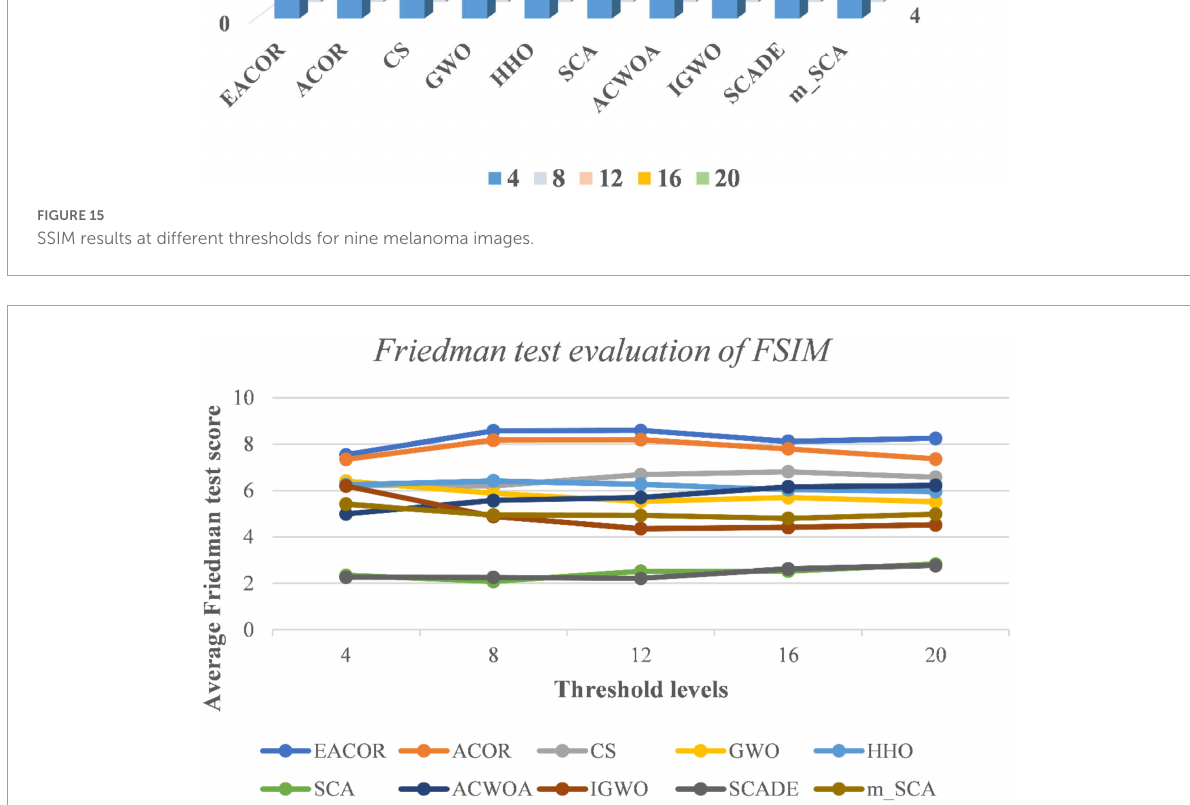
FIGURE16 FT result of FSIM evaluation at different thresholds for nine melanoma